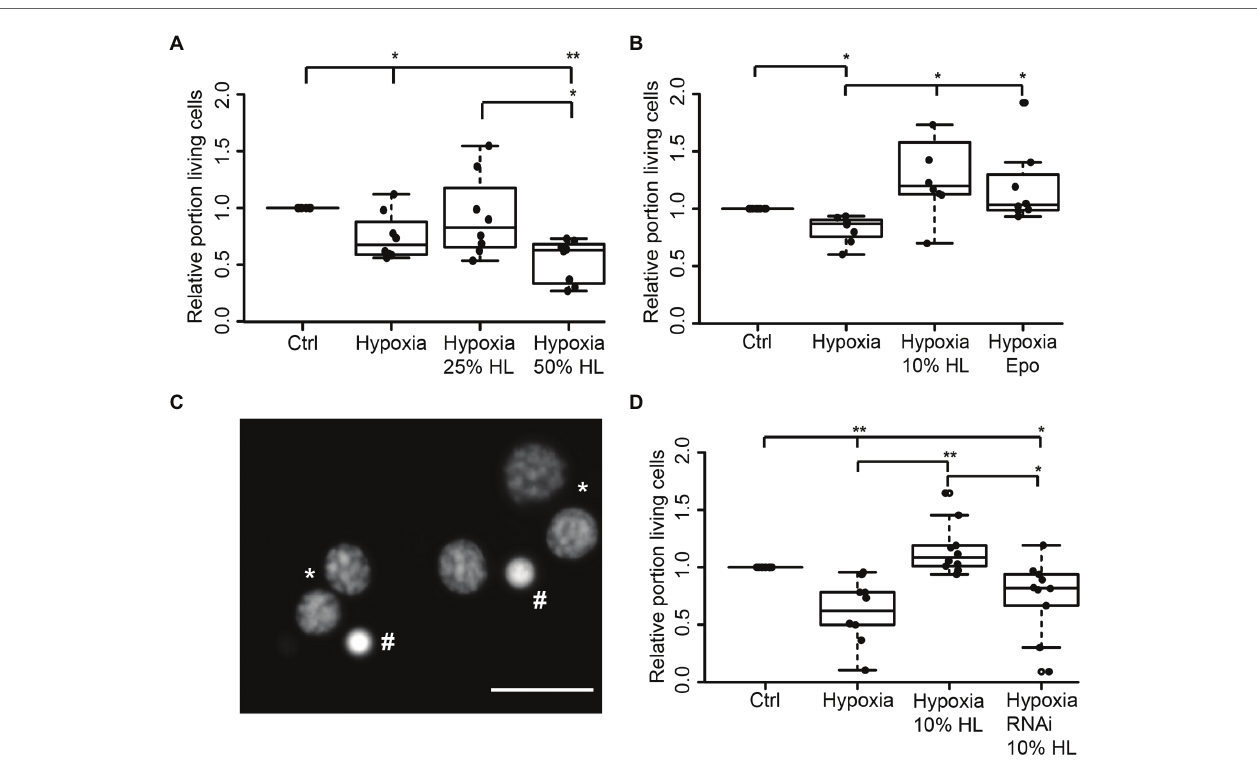
FIGURE 3 | Impact of locust hemolymph on survival of hypoxia-exposed locust neurons in vitro . (A) Relative survival of hypoxia-exposed (O 2 < 0.3% for 36 h) primary neurons. Exposure to hypoxia decreased relative survival of neurons in comparison to normoxic control ( p < 0.05). Twenty-five percent HL did not alter cell survival to either the control nor to the hypoxia group, while treatment with 50% HL significantly decreased cell survival to control cultures and cultures treated with 25% HL ( p < 0.01 and p < 0.05, respectively). n = 8; 180,563 cells evaluated. (B) Hypoxia-induced cell death ( p < 0.05 compared with normoxic control) is prevented by 10% HL supplementation ( p < 0.05 compared with hypoxic control; no difference to normoxic control). Similarly, 33.3 ng/ml Epo increases relative survival in hypoxic conditions to normoxic control levels. n = 8; 152,703 cells evaluated. (C) Survival of neurons was evaluated on the basis of fluorescent DNA labeling with Dapi. Intact neurons display patchy chromatin labeling (*) while dead/dying cells show uniform staining of condensed chromatin (#). Scale bar 10 μ m. (D) Locust hemolymph protects neurons from hypoxia-induced apoptosis by activation of cytokine receptor-like factor 3 (CRLF3). Hypoxia significantly ( p < 0.01) decreased relative survival of neurons compared to normoxic control. Hypoxia-induced cell death was prevented by addition of 10% HL to cell culture medium ( p < 0.01 compared to hypoxic control). RNAi-mediated knockdown of crlf3 expression abolished cell protective effects of locust HL on hypoxia-exposed neurons. Relative survival in RNAi- and HL-treated hypoxia-exposed neuron cultures was not different from hypoxic controls and significantly reduced compared with 10% HL-treated hypoxia-exposed cultures ( p < 0.05). n = 10; Cells evaluated: 143,587. Statistics: pairwise permutation test followed by Benjamini Hochberg correction. * p < 0.05; ** p <